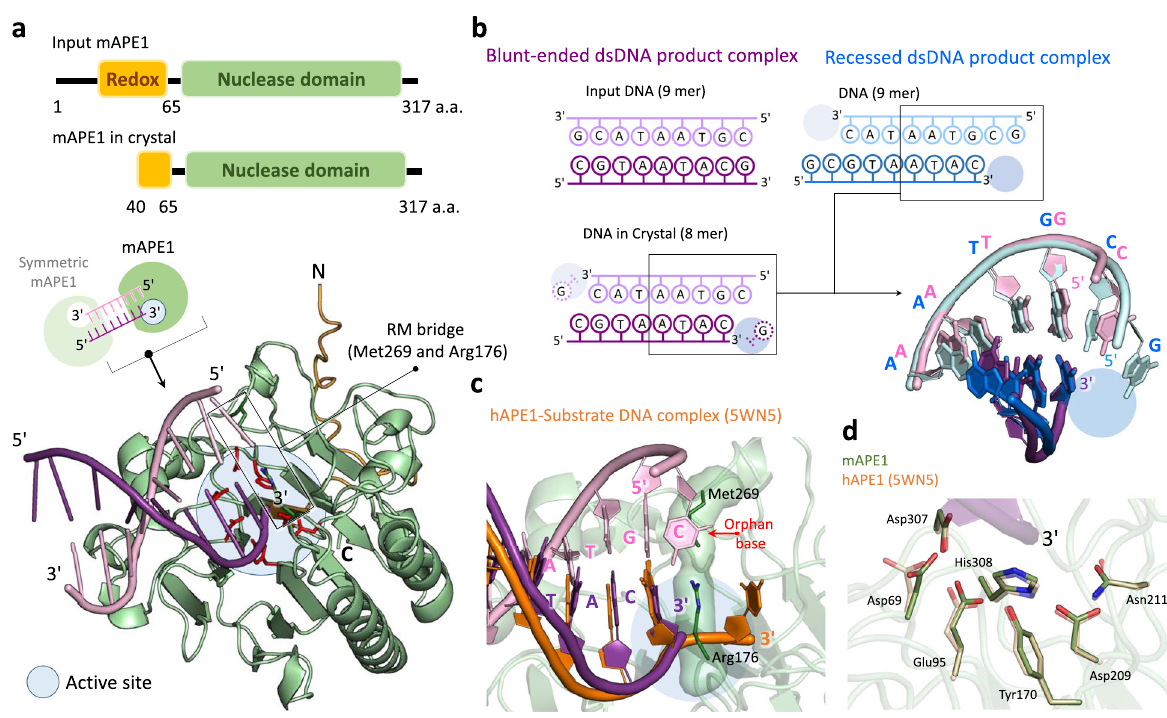
Fig. 4 Structures of mAPE1 blunt-ended dsDNA product complex and mAPE1-recessed dsDNA product complex. a The domain structure, crystal packing and overall structure of the mAPE1 blunt-ended dsDNA product complex. The redox domain and nuclease domain are colored in orange and green, respectively. b The schematic presentation of the two dsDNAs in the two product complex structures. Bottom right panel: structural alignment of the two dsDNAs in the two product complex structures. The active sites are highlighted by blue circles. c Structural alignment of mAPE1 blunt-ended dsDNA product complex and hAPE1-substrate DNA complex (PDB entry: 5WN5). It can be seen that the last nucleotide in the 3 ′ -end of dsDNA in our product complex is missing. Only the scissile strand of dsDNA in the hAPE1-substrate DNA complex (colored in orange) is displayed. d Superposition of active sites in mAPE1 blunt-ended dsDNA product complex and hAPE1-substrate DNA complex. The active site residues in the hAPE1-substrate DNA complex are colored by light orange and displayed in a transparent cleavage (Fig. 5e, the APE1-AP site-dsDNA structure, PDB entry: 5DFI), but the presence of base would cause a steric clash, hence explaining the molecular origin for the AP-site speci fi city of APE1 as an endonuclease.